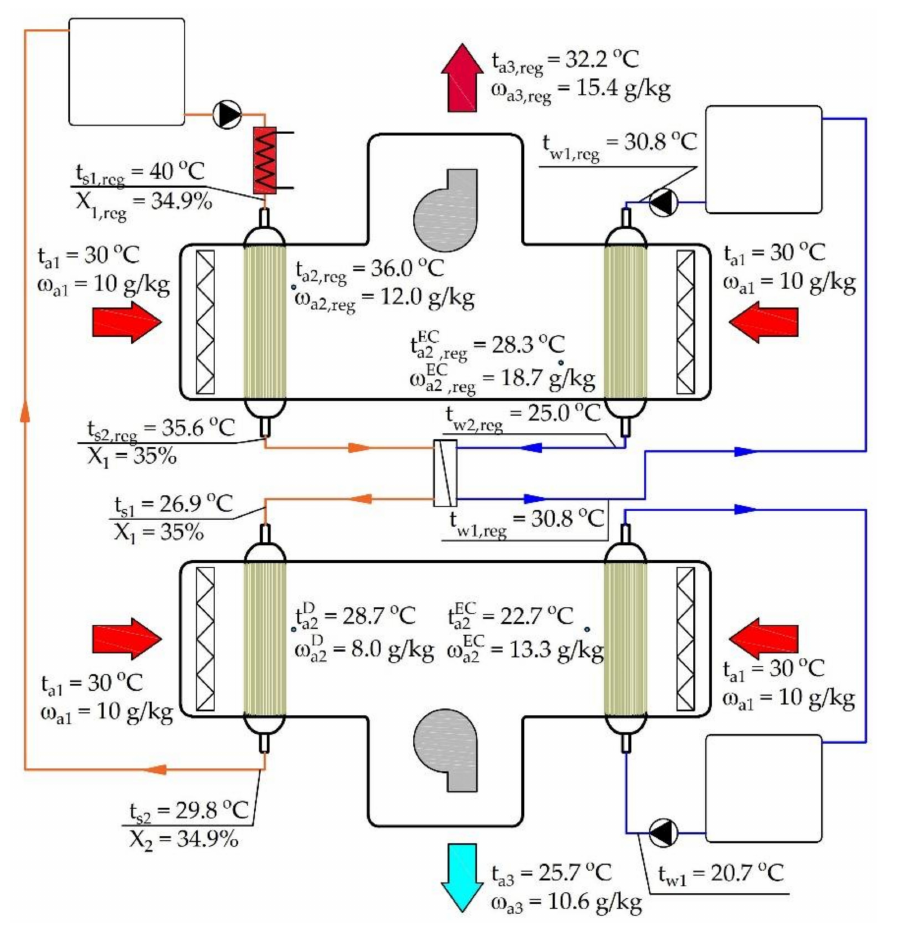
Figure 9. Examples of air and liquid